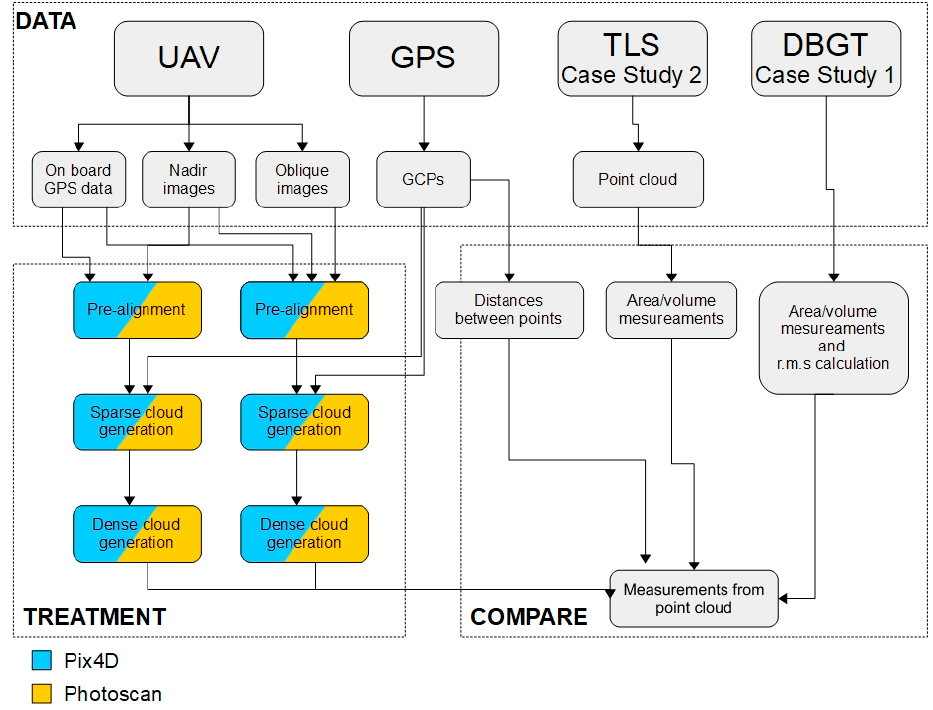
Figure 3. Workflows for 3D point cloud generation and their comparison with Terrestrial Laser Scanner (TLS) and DGBT.